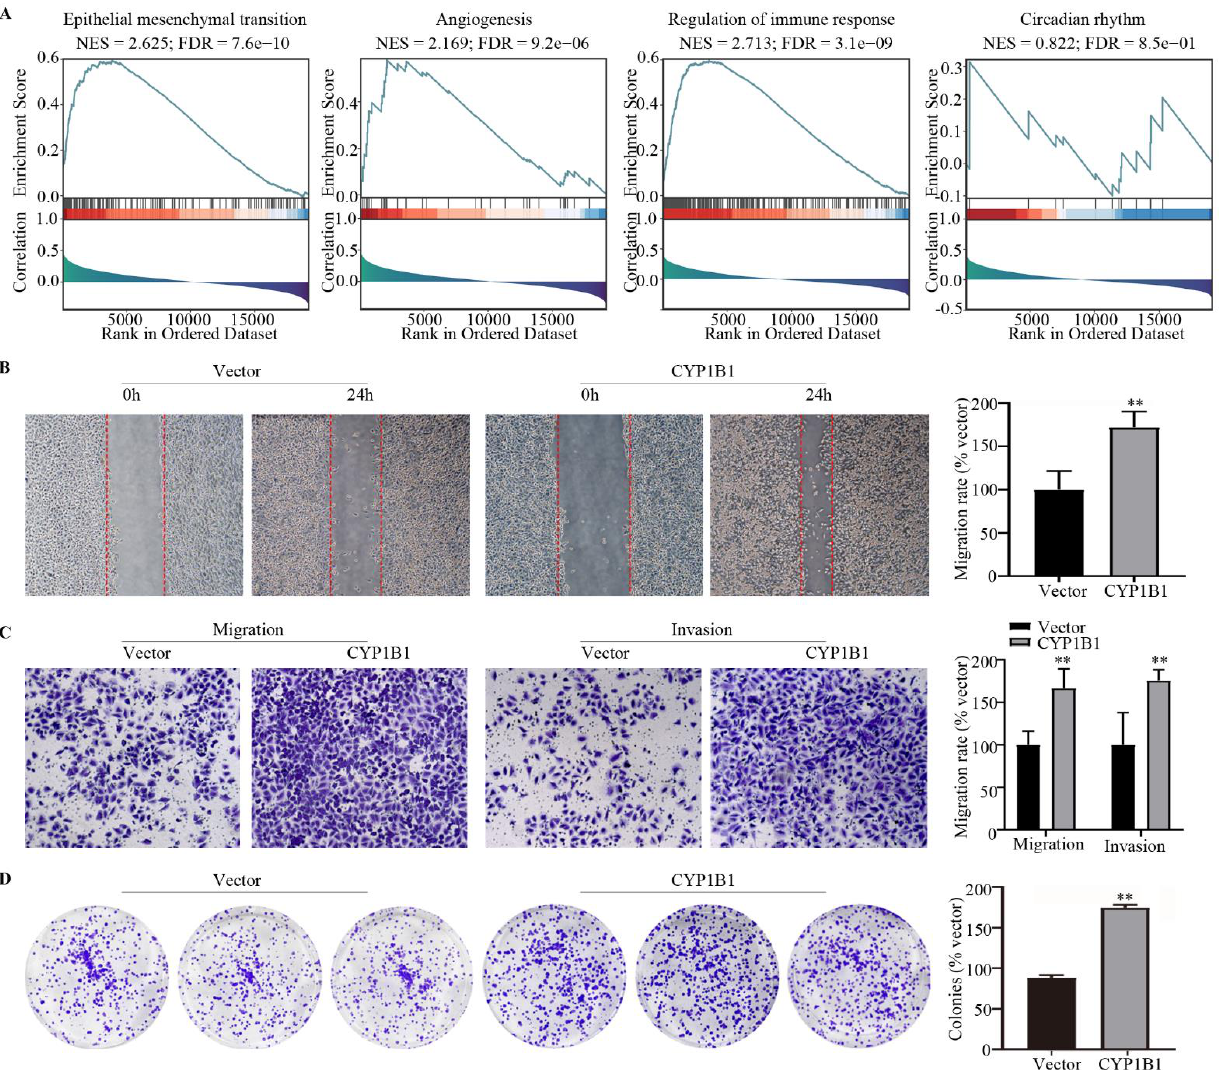
Figure 5. The function of CYP1B1 in vitro. ( A ) GSEA analysis of CYP1B1 in breast cancer. ( B ) Wound healing of CYP1B1. ( C ) Transwell migration and invasion assay of CYP1B1. ( D ) Colonies assay of CYP1B1. ** p < 0.01.